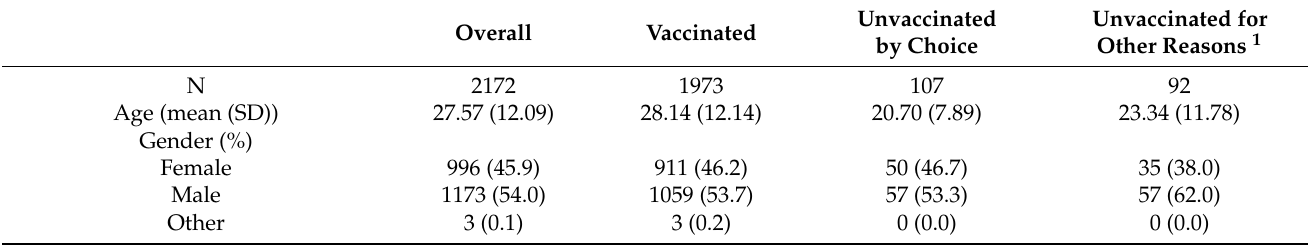
Table 1. Study characteristics of the overall study population and subgroups stratified by vaccinated, unvaccinated by choice, and unvaccinated for other reasons. Overall Vaccinated